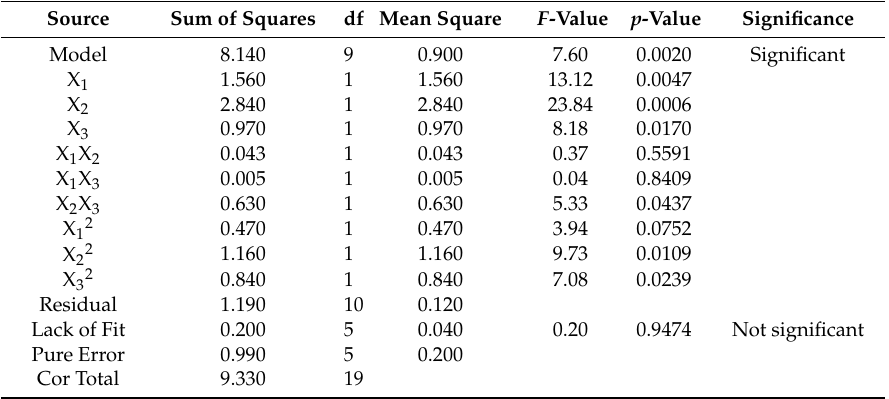
Table 4. ANOVA of the central composite